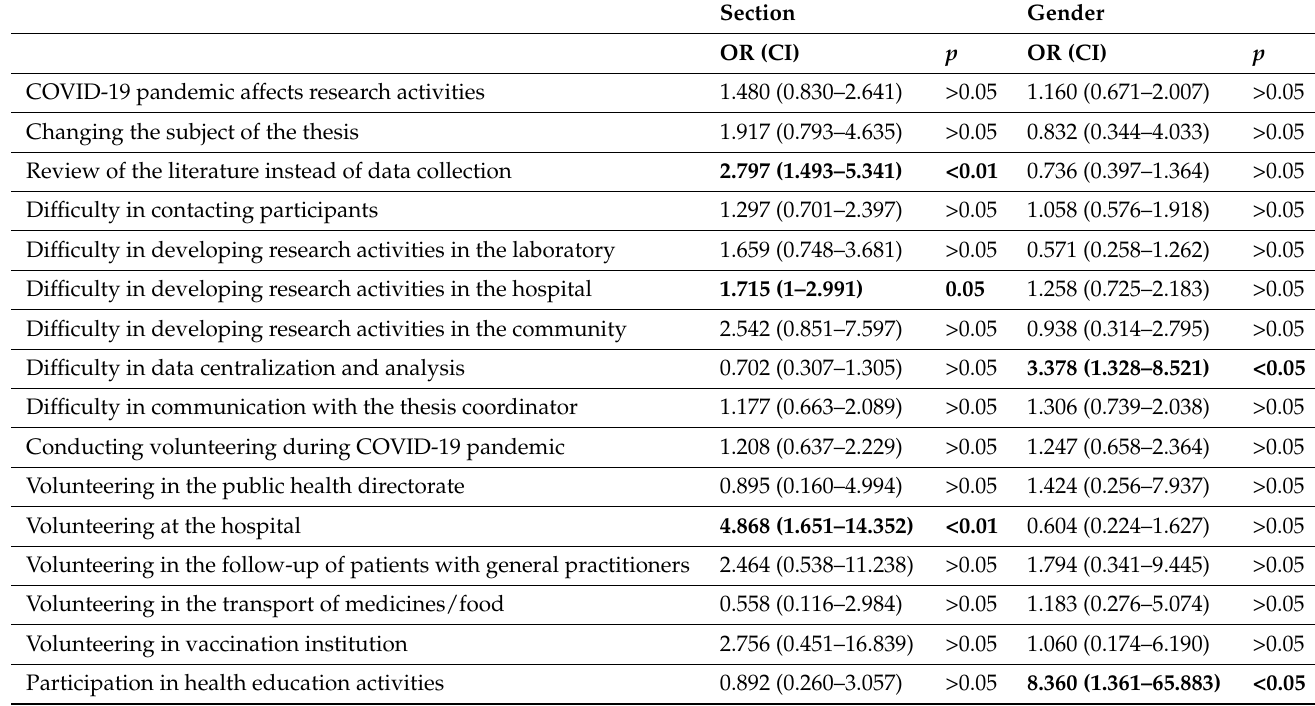
Table 3. Factors associated with the impact of the COVID-19 pandemic on research and volunteering